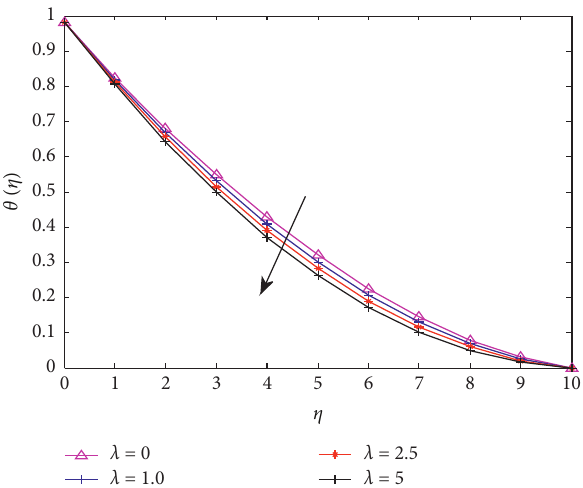
Figure 13: Temperature sketch for altered values of λ when Pr � 0 . 72, Ω � M � R � s � 1, β � 0 . 2, c � 0 . 2, and Ec � 0 . 1.